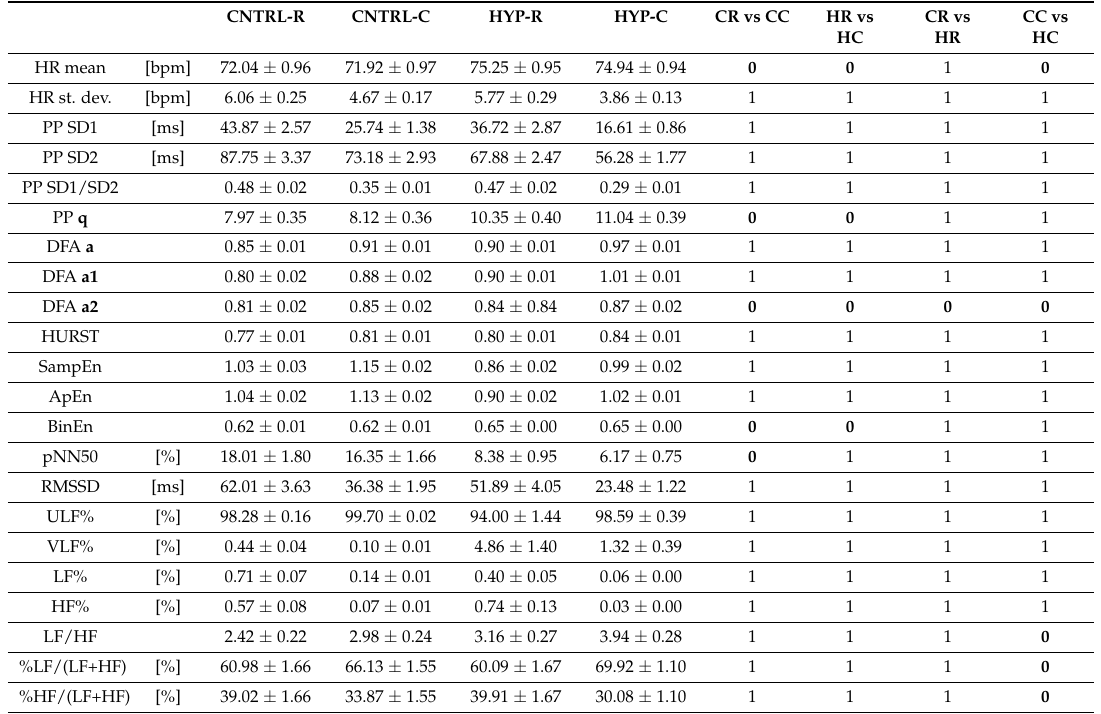
Table 3. Values of the cardiovascular features of hypertensive (HYP) and control (CNTRL) subjects; the signals are raw (R) and corrected